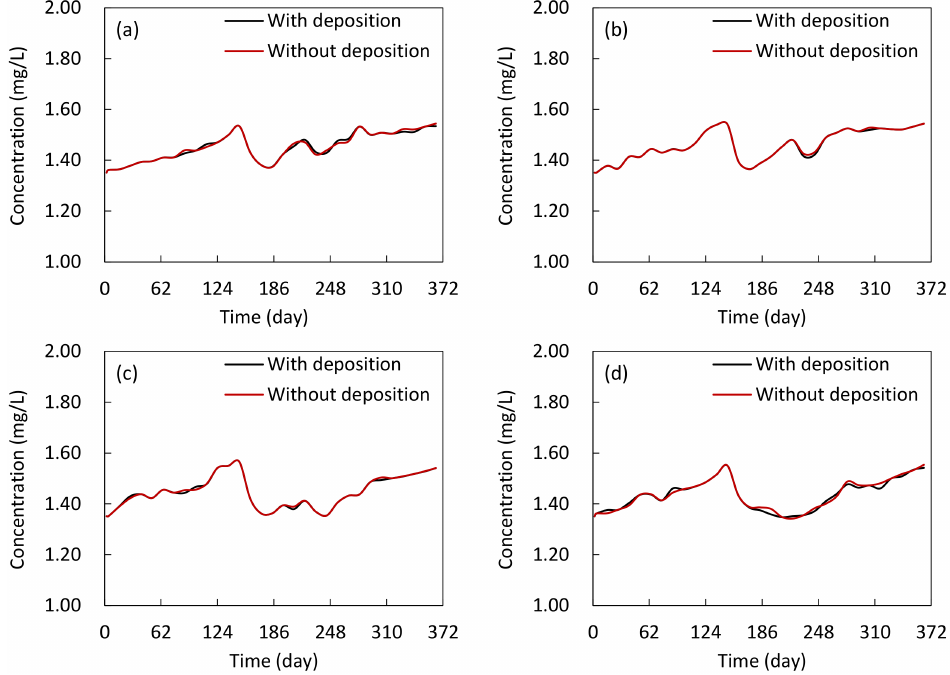
Figure 8. The simulated concentration of TN at four observing points in Miyun Reservoir: ( a ) Kuxi, ( b ) Kudong, ( c ) Jingou, and ( d ) Dam of